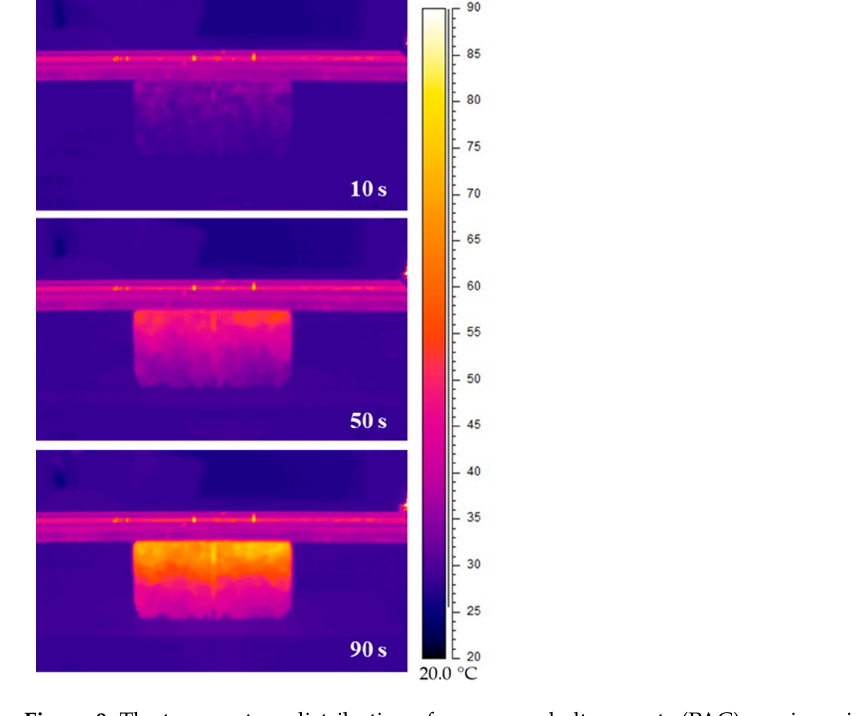
Figure 9. The temperature distribution of porous asphalt concrete (PAC) specimen in the induction heating test [27].